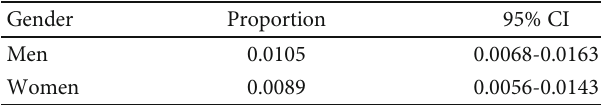
Table 2: Gender-speci fi c risk of CRC in UC patients.